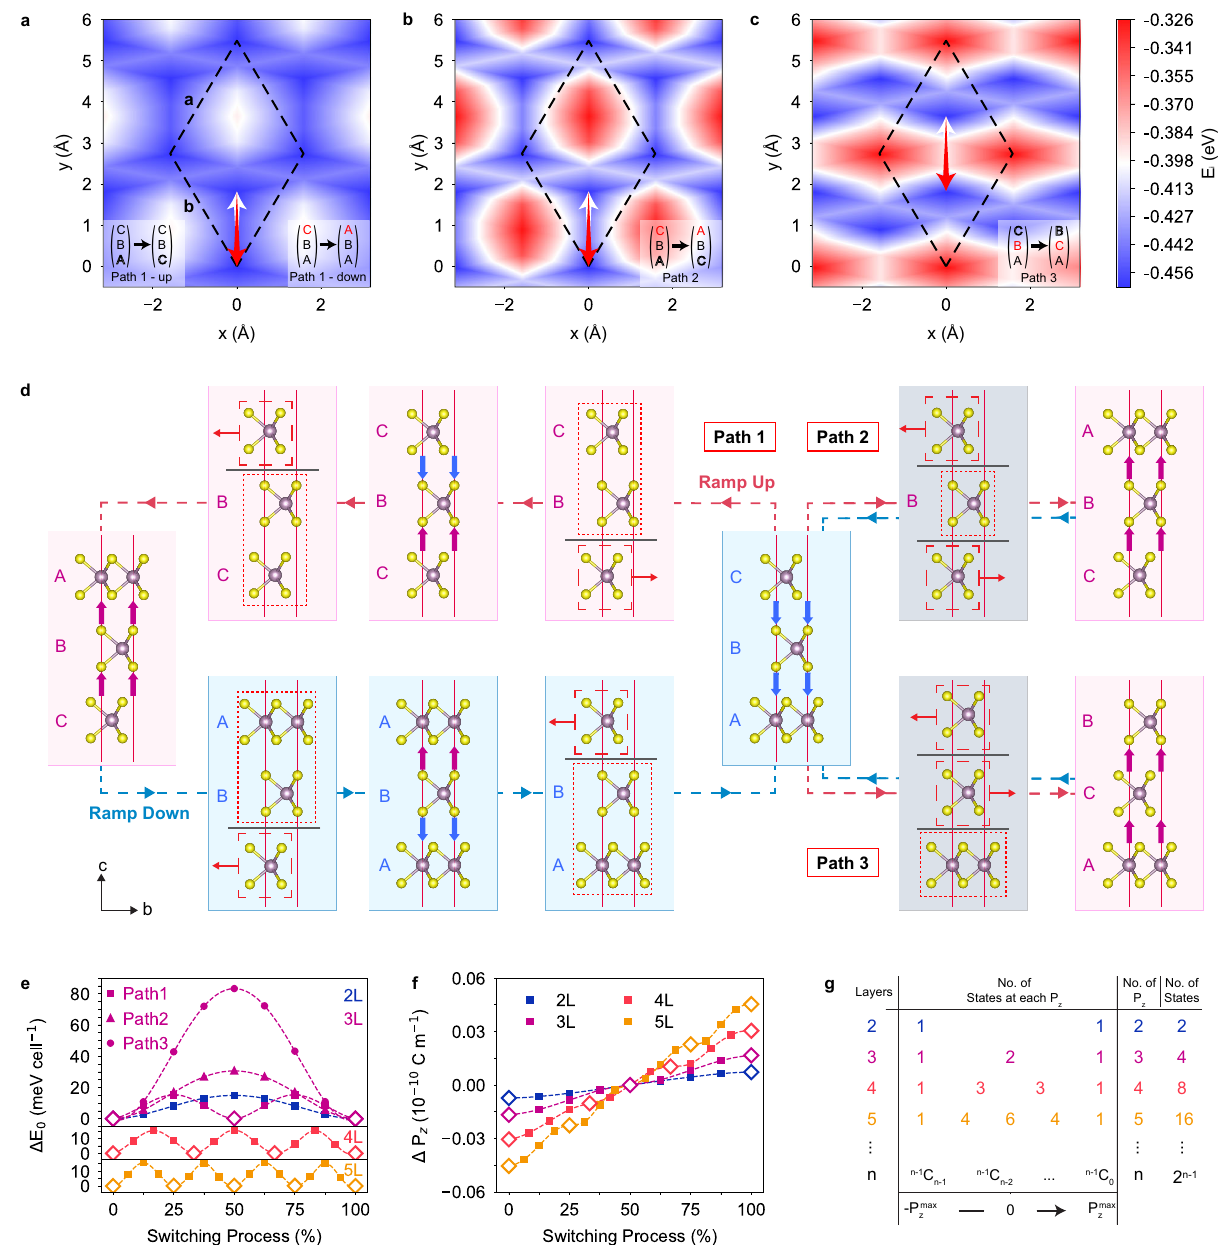
Fig. 4 | Theoretical analysis of ferroelectric switching in n -layer 3R MoS 2 . Potentialenergysurfacesexperiencedbythetranslatingatomiclayer(s)when a the other two layers are adjacent and stationery, b when they are not adjacent but are translating simultaneously and c when they are adjacent and translating simulta- neously. For ferroelectric switching pathways that match each of the above cases, arrowsin a – c indicatetheinitialand fi nalplanarpositionsofthetranslatingatomic layers ’ Mo atoms. The initial and fi nal stacking orders of the translations are pre- sented in the inset of each sub- fi gure. Translating atomic layers and their corre- sponding arrows in each sub- fi gure share the same color. d Path 1, 2, and 3 of ferroelectricswitchingintrilayer3RMoS 2 .Atomicstructuresat0%,25%,50%,75%, and 100% of the switching processes are shown. Red dashed (dotted) boxes indi- cate the moving (stationary) blocks. Gray horizontal lines indicate the sliding interfaces. The solid red horizontal arrows mark the displacement direction of the individual blocks. Atomic structures without solid red horizontal arrows are stable